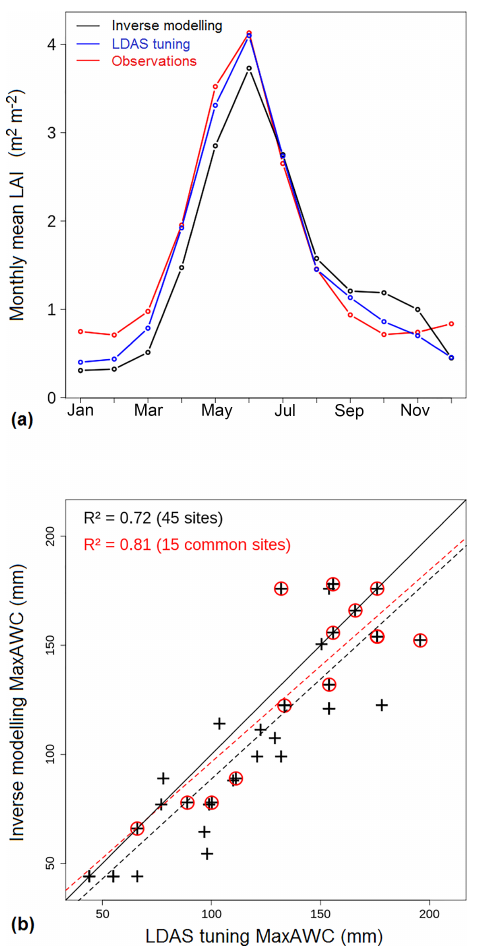
Figure 10. Inverse modelling vs. LDAS tuning: (a) mean LAI an- nual cycle for 15 validated départements with both methods from satellite-derived observations (red line), inverse modelling (dark line) and LDAS tuning (blue line); (b) MaxAWC comparison for ( + ) all 45 départements ( R 2 = 0.72) and for (red circles) the 15 common départements ( R 2 =